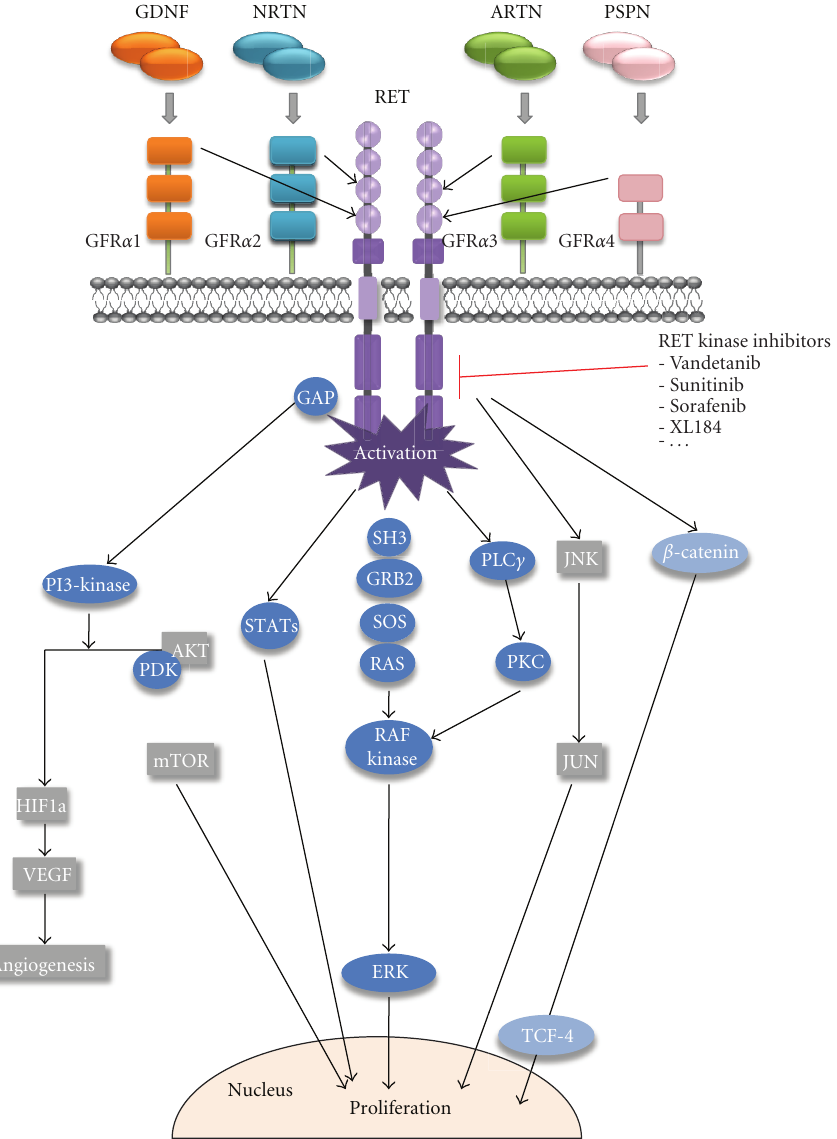
Figure 1: Outline of RET signalling